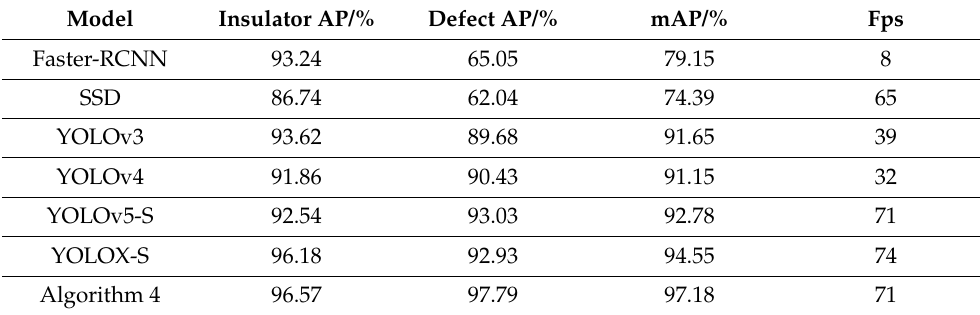
Table 5. Detection accuracy of different models at